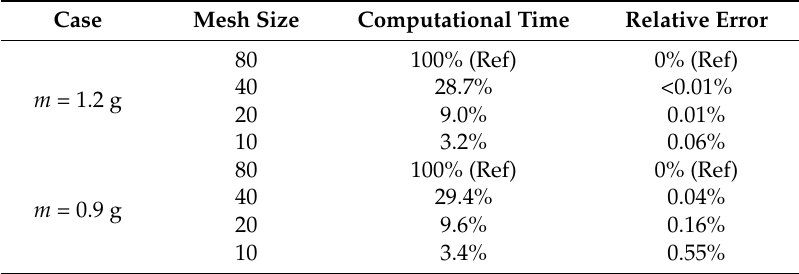
Table 1. Computational efficiency.